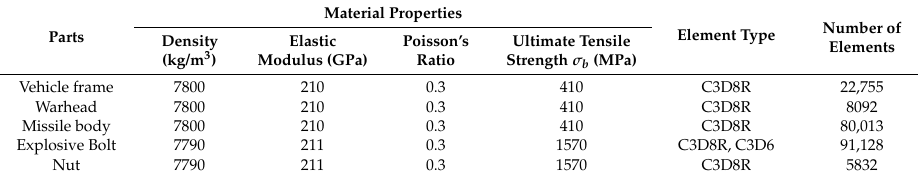
Table 3. Contacts and constraints sets of missile vehicle.